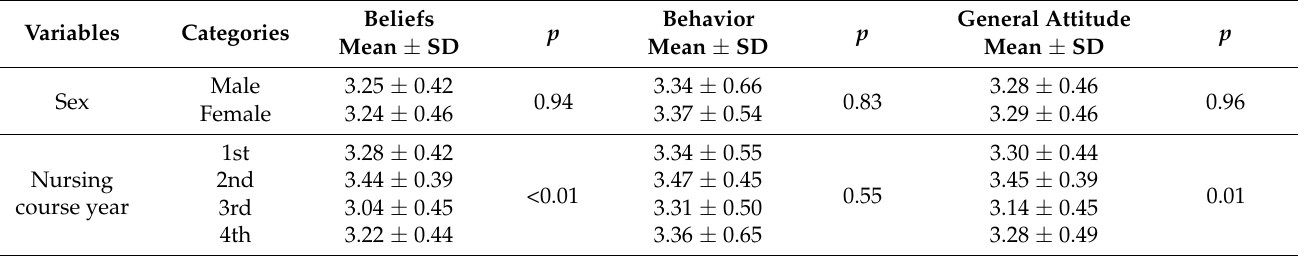
Table 2. Distribution of scores for ACVECS questionnaire dimensions with respect to sex and nursing course